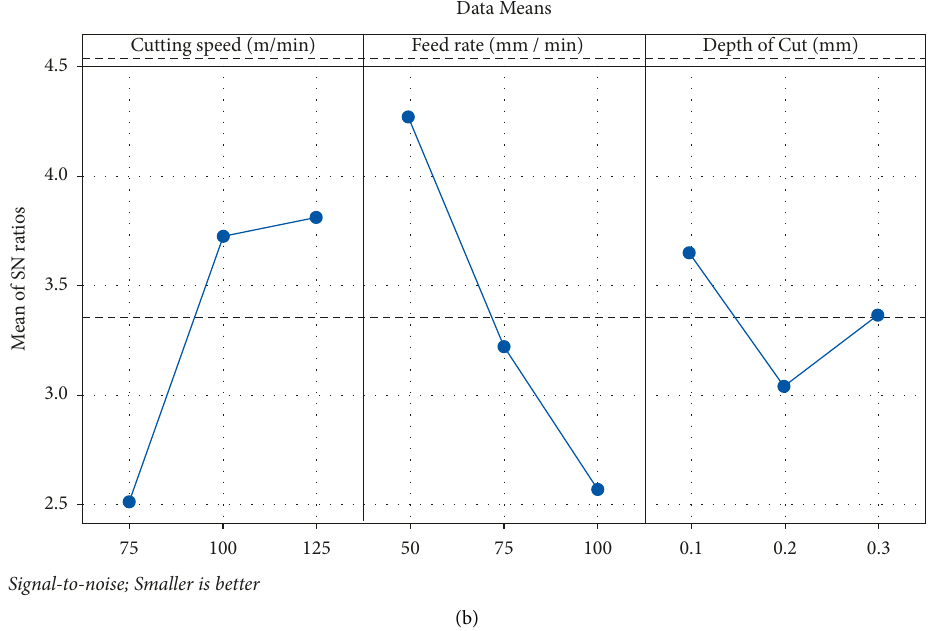
Figure 4: (a) Meansplot forthe surfaceroughnessofmilled AM component.(b) S/Nratioplot for thesurface roughnessofmilledAM